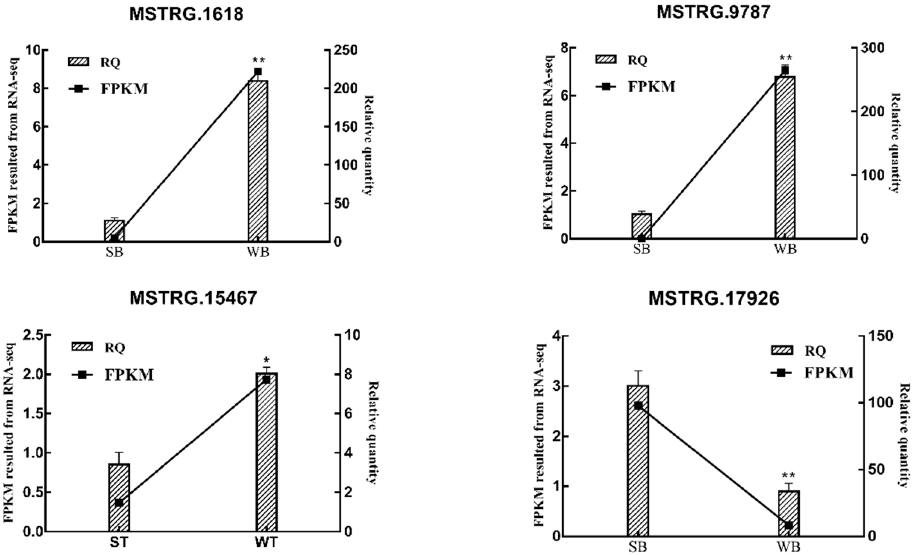
Figure 5. RT-qPCR results of lncRNAs with significant di ff erences in WB vs. SB and WT vs. ST comparison group. The figure shows the quantitative results of RNA-seq and RT-qPCR; the line graph shows the FPKM value of the sequencing and the histogram shows the relative quantitative results; the significance test: * p ≤ 0.05, ** p ≤ 0.01. WB, WT, SB, and ST represent WuTou donkey longissimus dorsi muscle, WuTou donkey gluteus muscle, SanFen donkey longissimus dorsi muscle and SanFen donkey gluteus muscle, respectively.